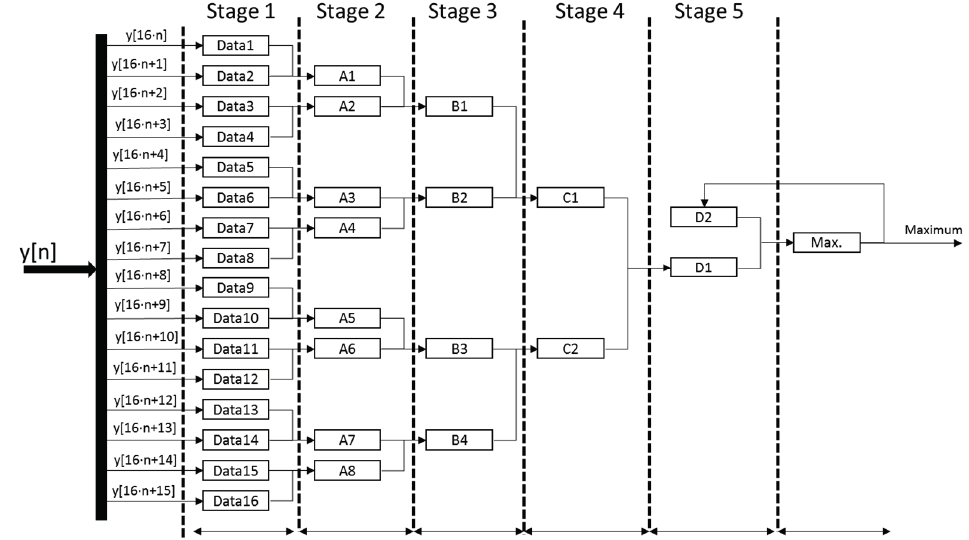
Figure 8. General scheme proposed for the implementation of the detector of the maximum correlation